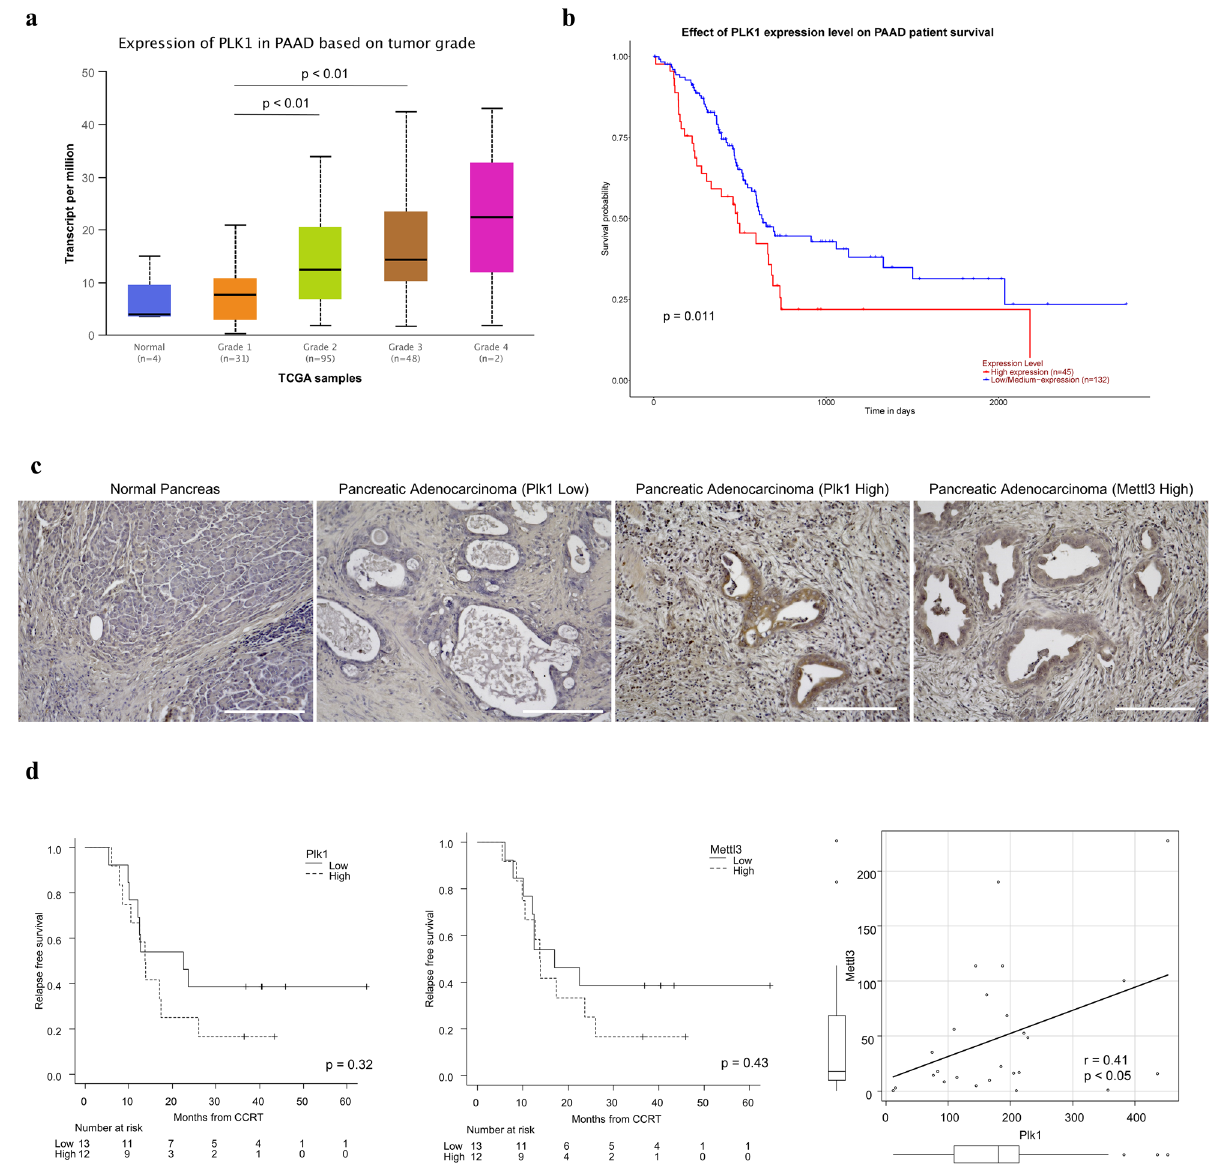
Figure 2. PLK1 is a poor prognostic factor for pancreatic adenocarcinoma. ( a , b ) Clinical impact of PLK1 from TCGA data via UALCAN (http:// ualcan. path. uab. edu/). ( a ) PLK1 is elevated in parallel with the pathological grade of pancreatic adenocarcinoma. ( b ) Patients with pancreatic cancer with elevated PLK1 have poor OS. ( c ) Histopathological images of PLK1 in patients with pancreatic adenocarcinoma (immunohistochemistry with DAB). PLK1 expression is low in healthy pancreatic tissue, whereas PLK1 is abundantly expressed in pancreatic adenocarcinoma tissue. Pancreatic adenocarcinoma with high METTL3 expression is also presented (same patient with high PLK1). The scale represents 200 µm. ( d ) High protein expression of PLK1 and METTL3 tends to be associated with poor prognosis in pancreatic adenocarcinoma. A positive correlation between PLK1 and METTL3 was also